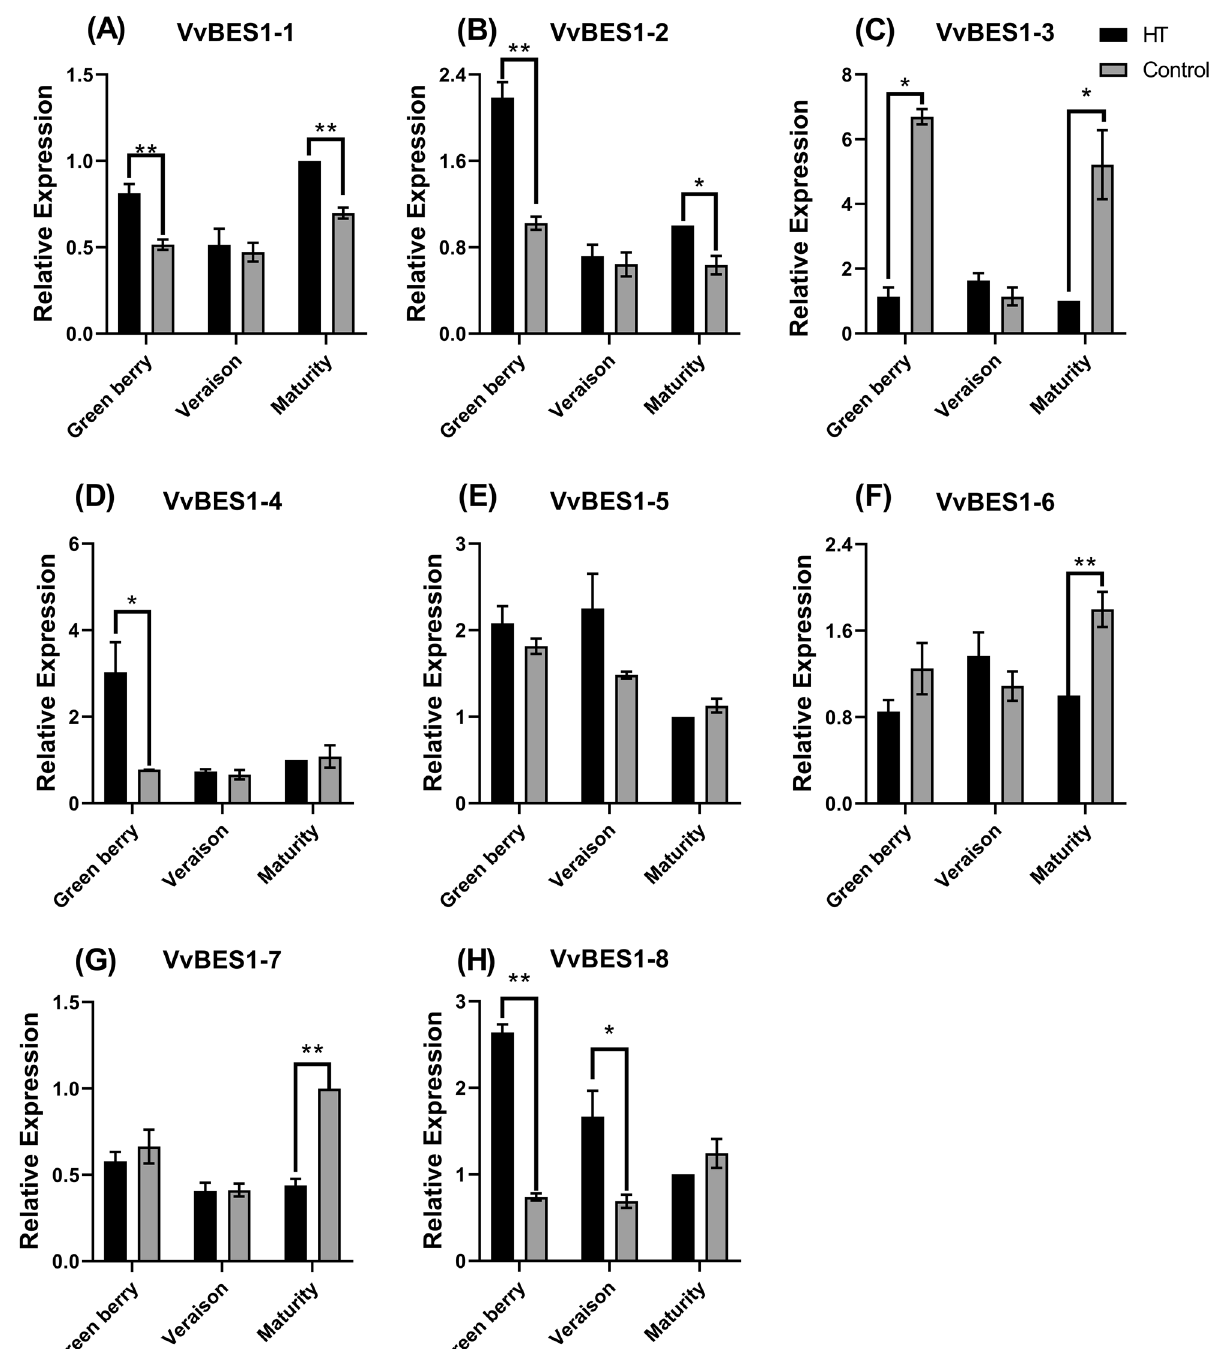
Figure 7. The expression profiles of VvBES1 genes in V. vinifera berry in response to heat stress at different developmental stages (green berry stage, veraison stage, maturity stage). ( A ) VvBES1-1 expression level. ( B ) VvBES1-2 expression level. ( C ) VvBES1-3 expression level. ( D ) VvBES1-4 expression level. ( E ) VvBES1-5 expression level. ( F ) VvBES1-6 expression level. ( G ) VvBES1-7 expression level. ( H ) VvBES1-8 expression level. The error bars represent ± SE (n = 3), and the relative expression changes are relative to the control group (maturity stage), which are represented as log 2 fold change. An independent sample T-test was implemented to assess the significance of differences between treatments (p <